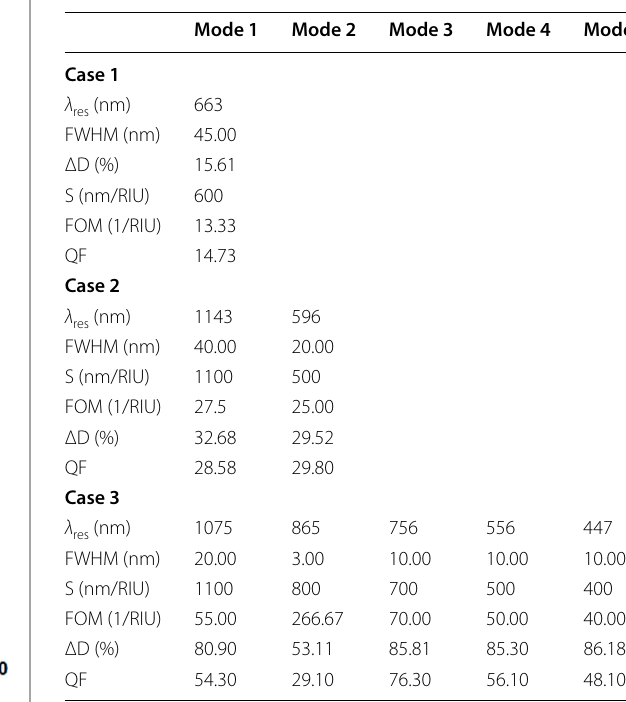
Table 1 Comparison of λ 1–3 structures at resonance